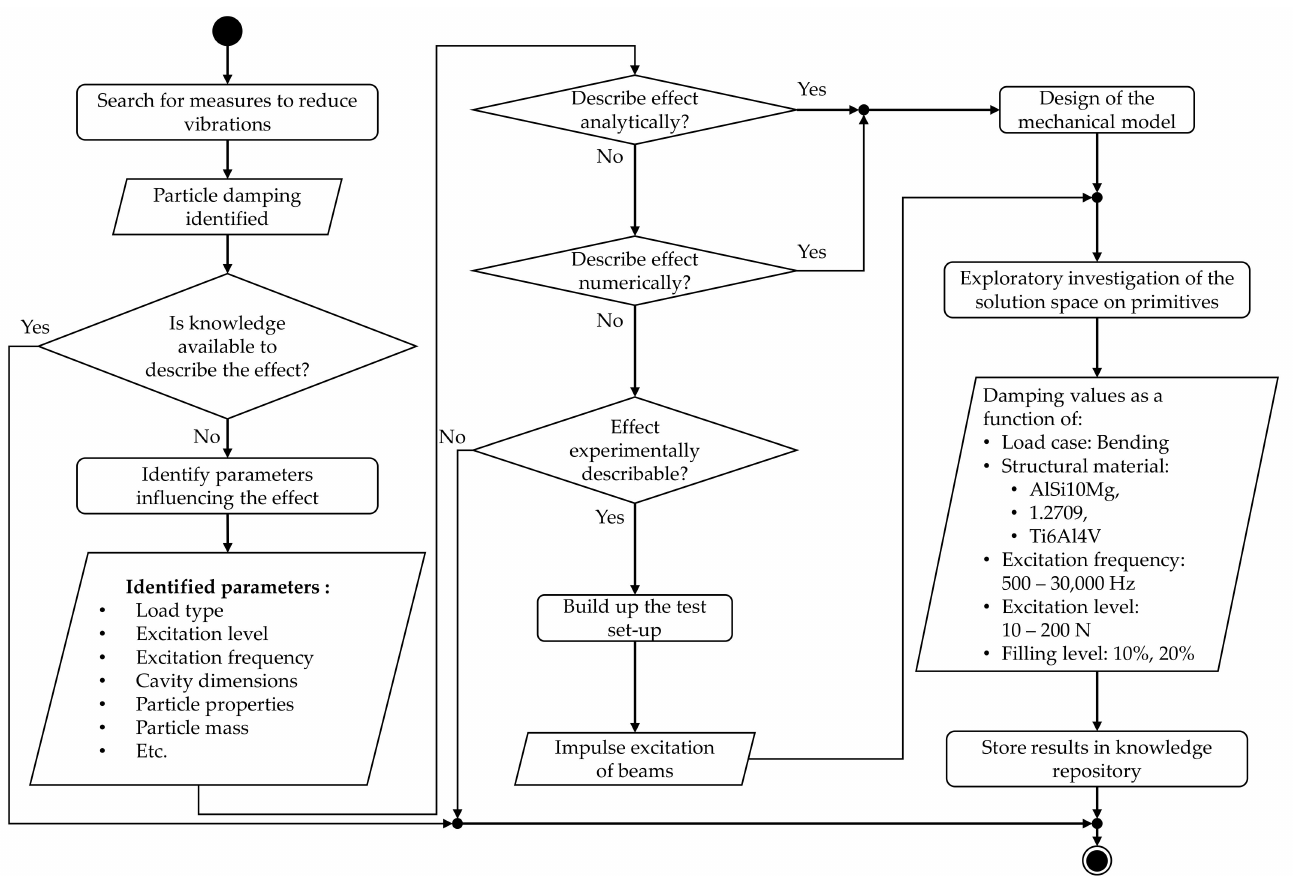
Figure 4. Flow chart to characterise the effect of particle damping.